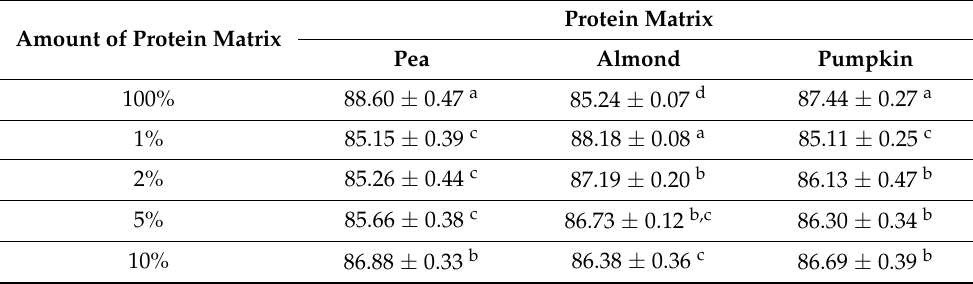
Table 2. Denaturation temperatures of protein matrices and protein complexes. Protein Matrix Amount of Protein Matrix Pea Almond Pumpkin 100% 88.60 ± 0.47 a 85.24 ± 0.07